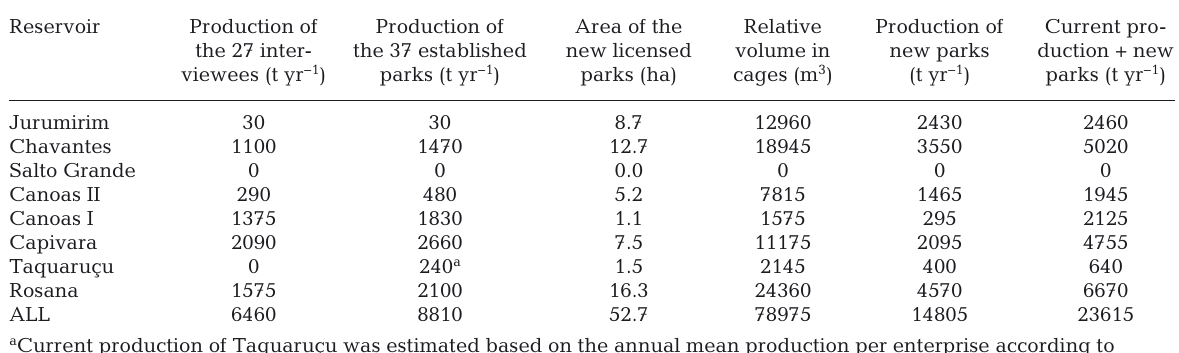
a Current production of Taquaruçu was estimated based on the annual mean production per enterprise according to information obtained from the interviewed producers